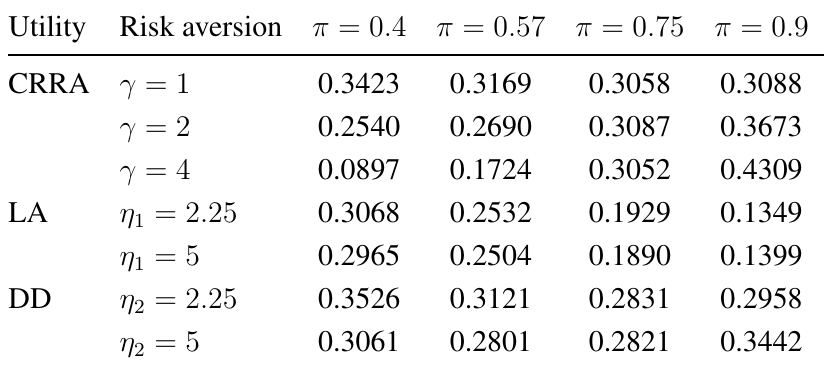
Table 1. Values of λ ∗ for the benchmark case. DD, mean-downside deviation